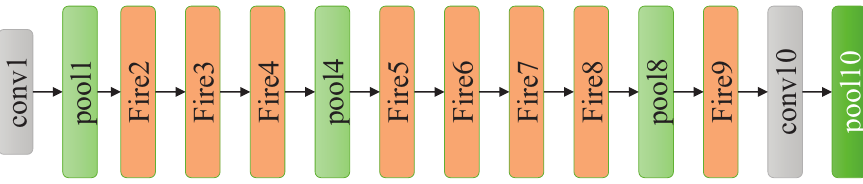
Figure 9. The architecture of SqueezeNet.